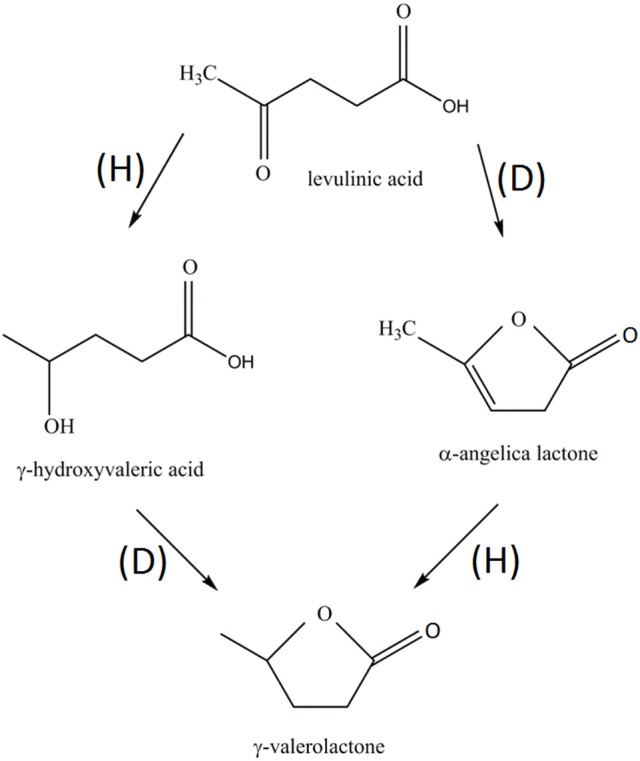
Pathway of catalytic hydrogenation (H) and dehydration (D) reactions involved in the transformation of levulinic acid to GVL.